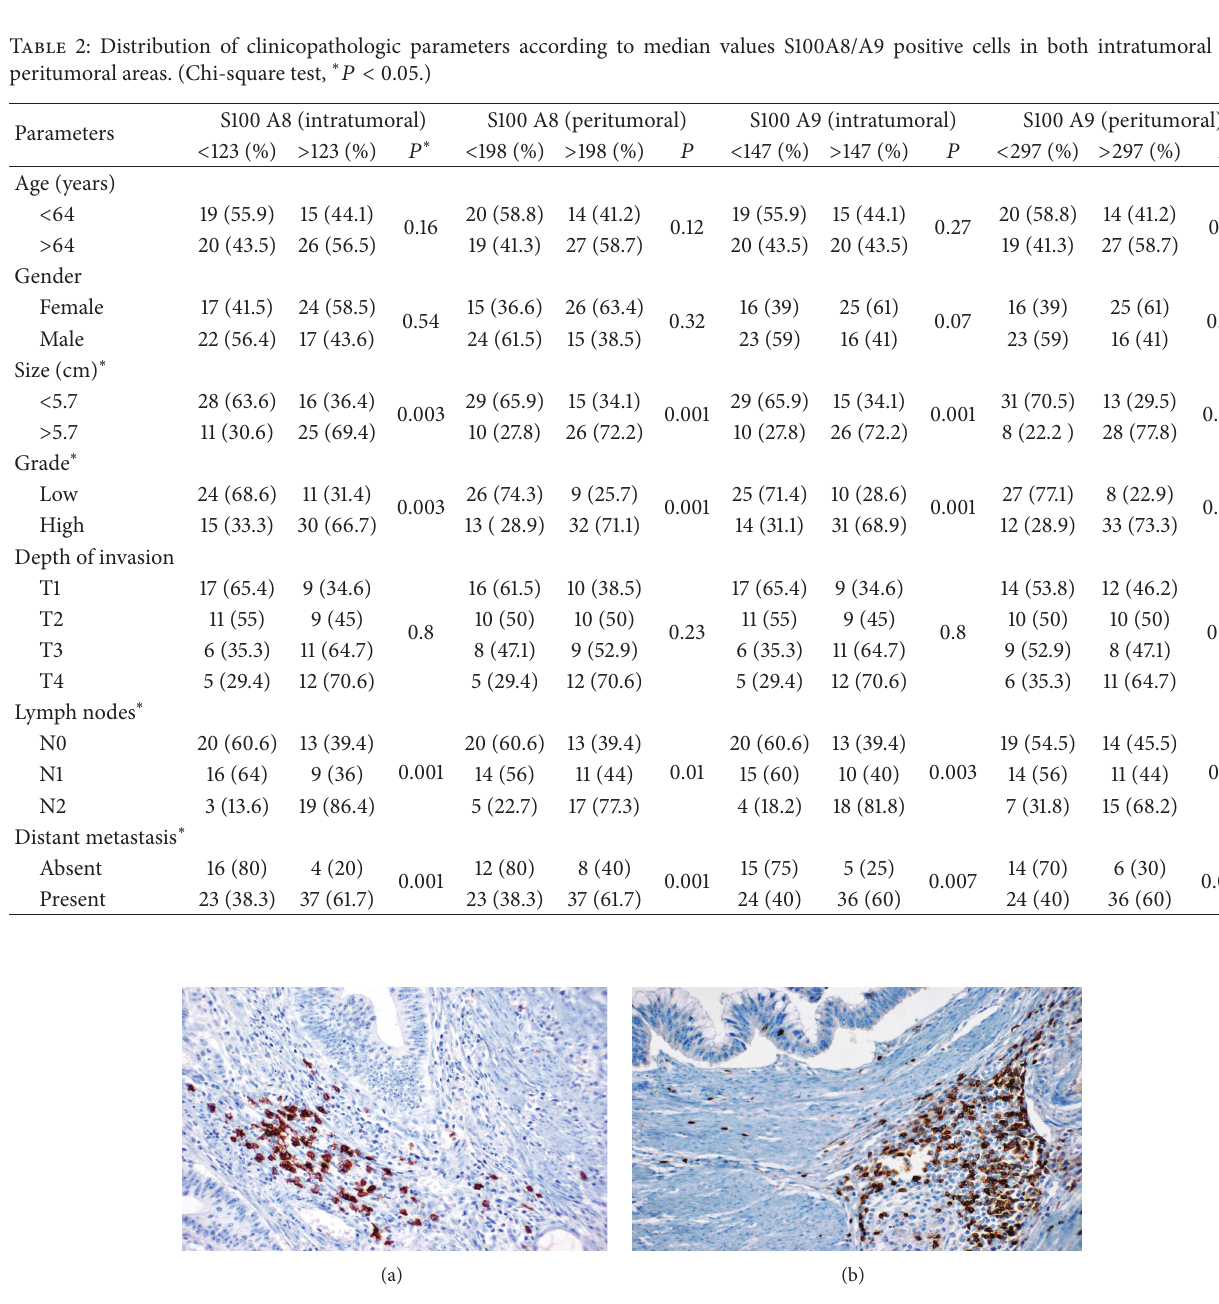
Figure 1: S100A8 staining in intratumoral (a) and peritumoral (b) inflammatory cells ( ×